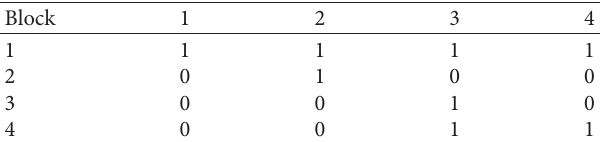
Table 5: Image matrix of the block models. Block